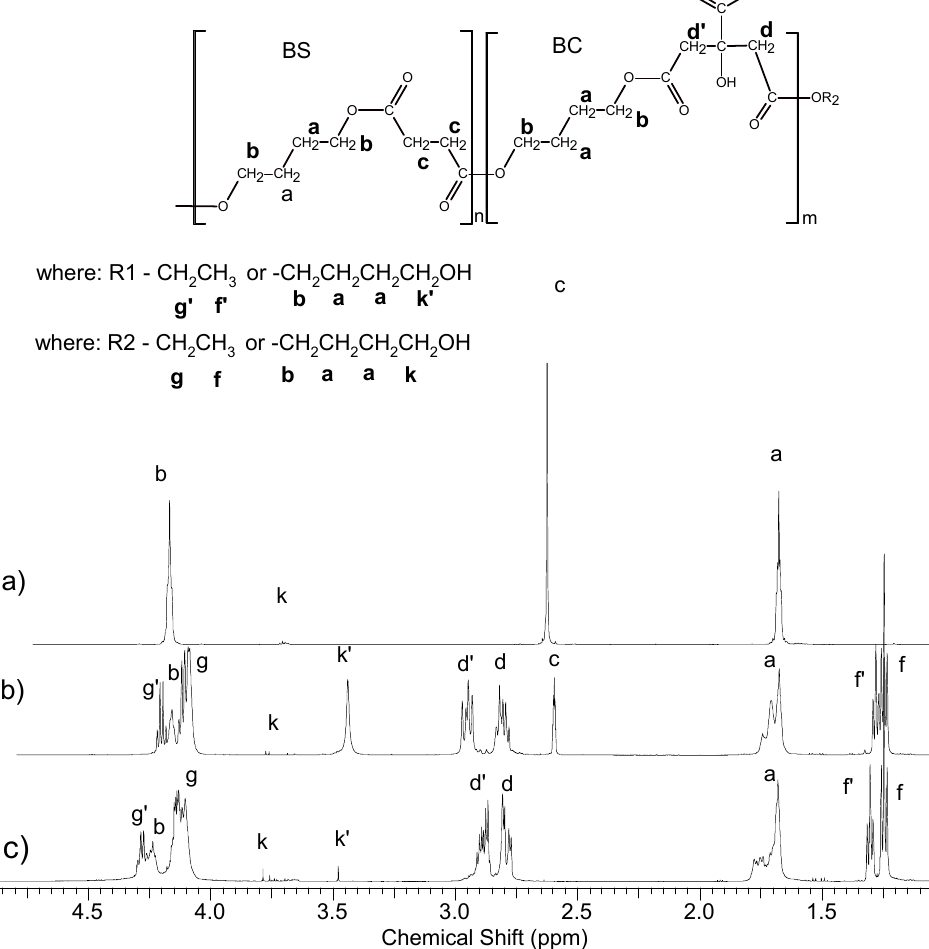
1 H NMR measurements of the obtained compounds after reaction with trichloroacetyl isocyanate were (at δ = 2.81 ppm and δ = 2.87 ppm, signal d, d—Figure 2) in the direction of δ = 3.32 ppm and